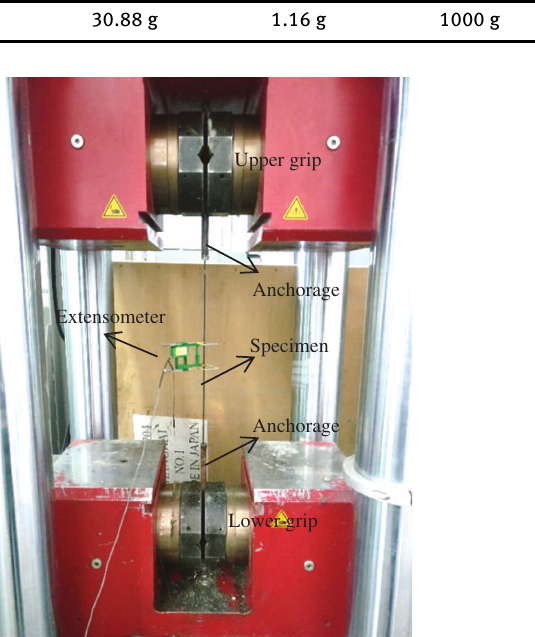
Figure 4: Tensile test equipment.